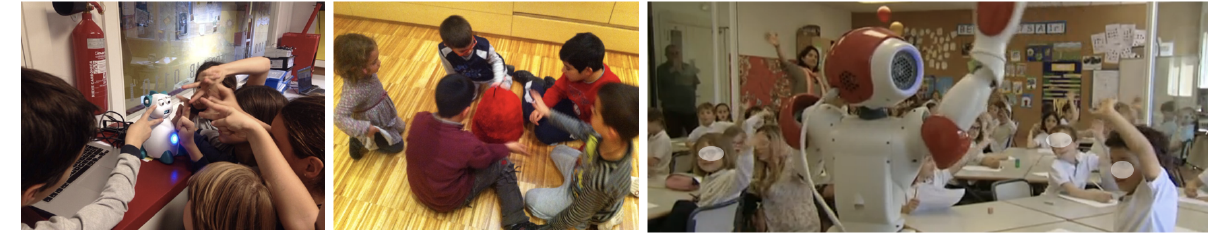
Figure 1: From left to right, a) the robot can have the function of social agent, b) robot as a playful tool, and c) robot as a coach.